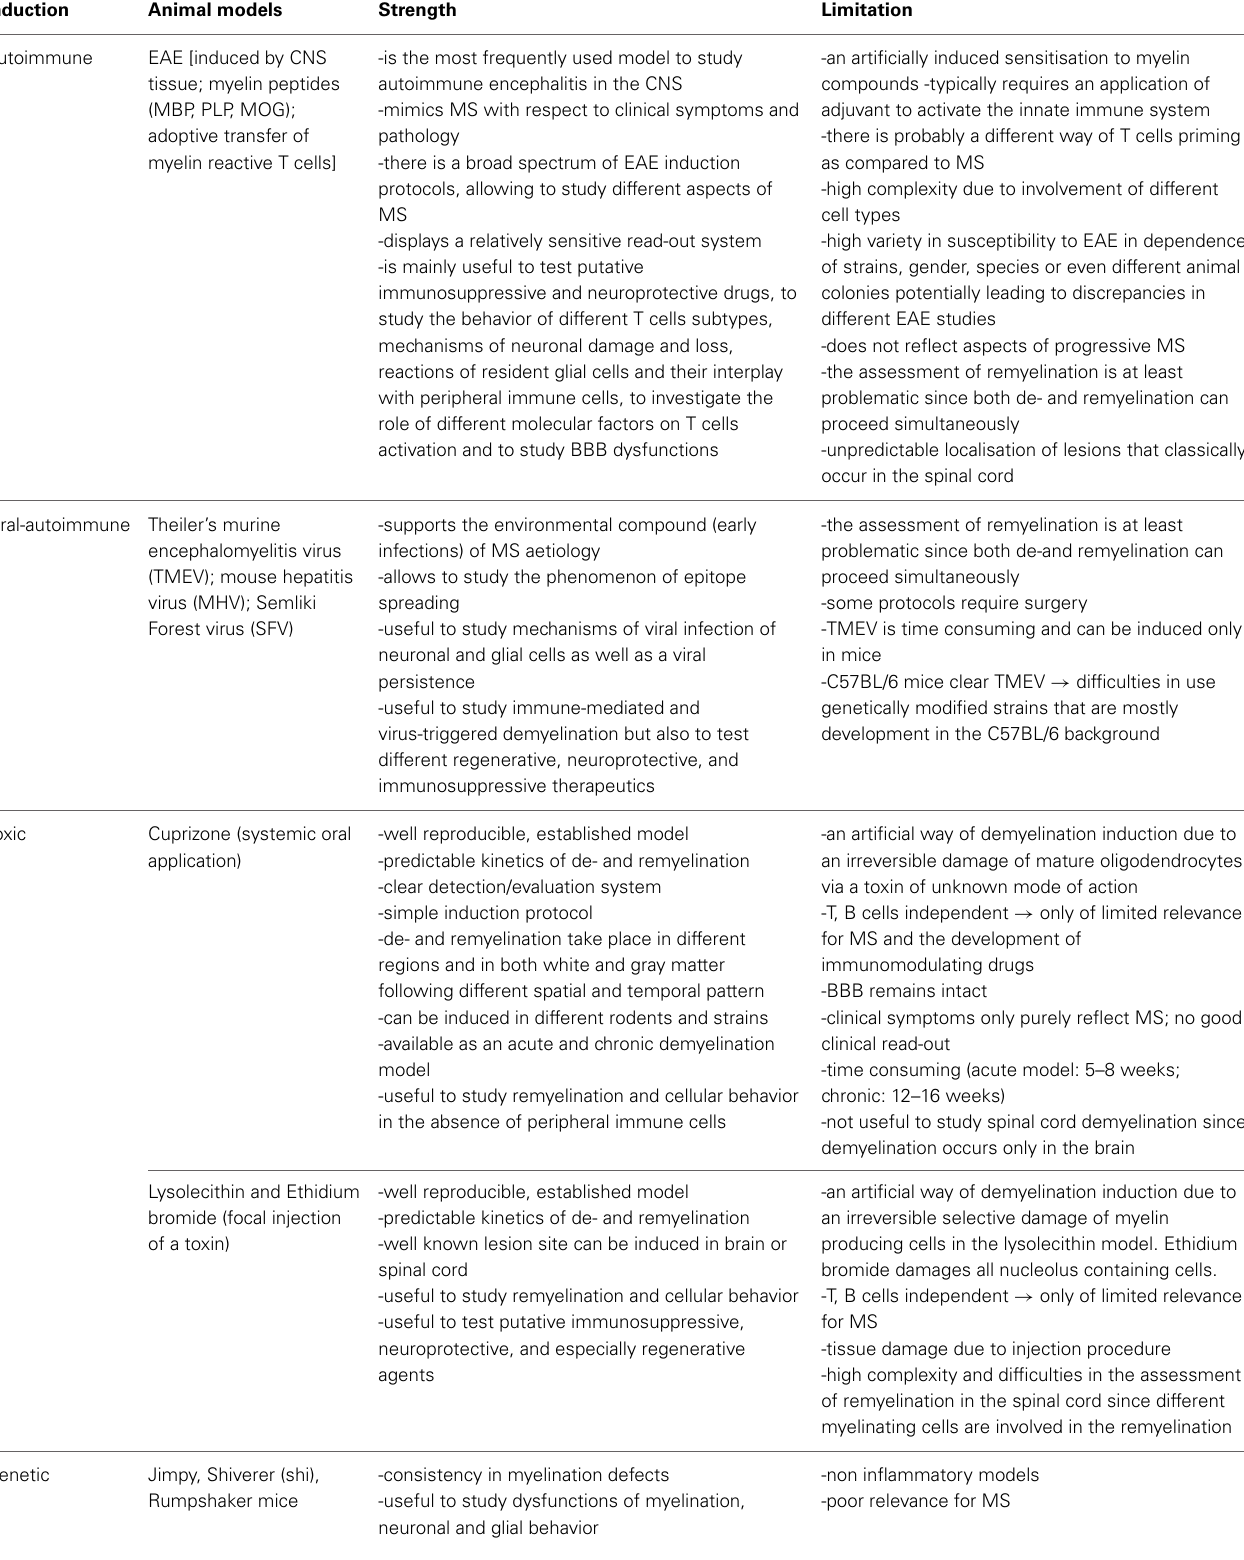
Table 1 | Advantages and disadvantages of different animal models available to study the broad spectrum of MS-relevant